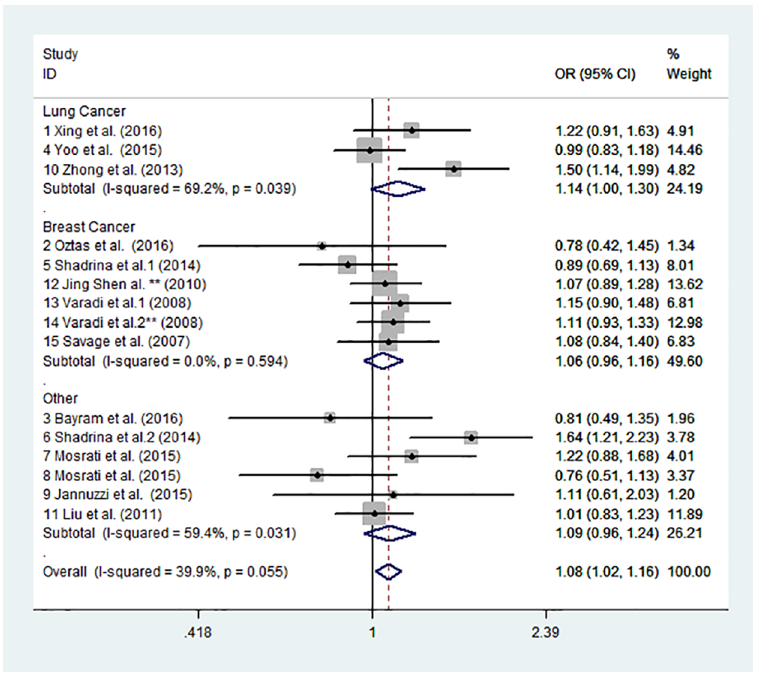
Fig 2. Forest plot of homozygote comparison (CT versus TT) for overall comparison, using a fixed-effects model.